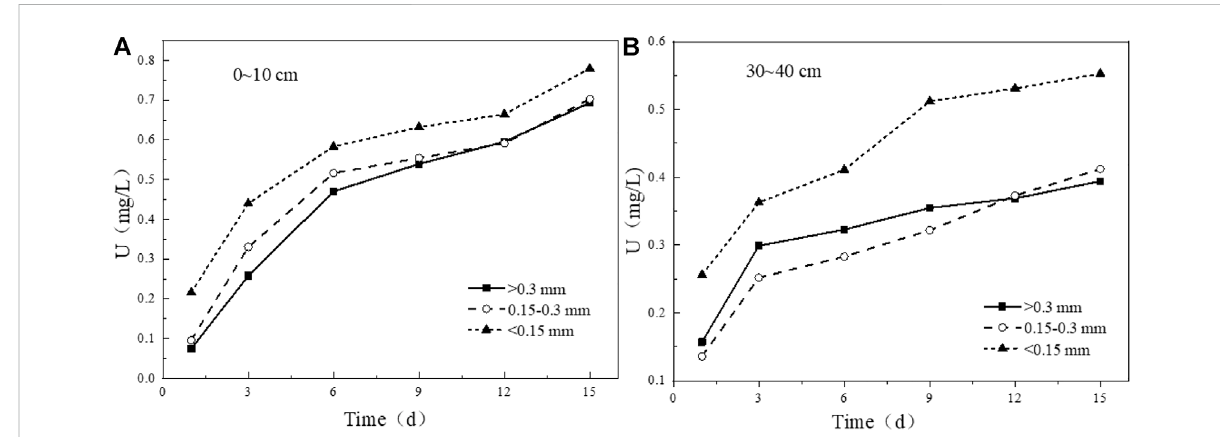
FIGURE 13 Variation of uranium leaching concentration under different particle size conditions. (A) 0 – 10 cm; (B) 30 – 40 cm.